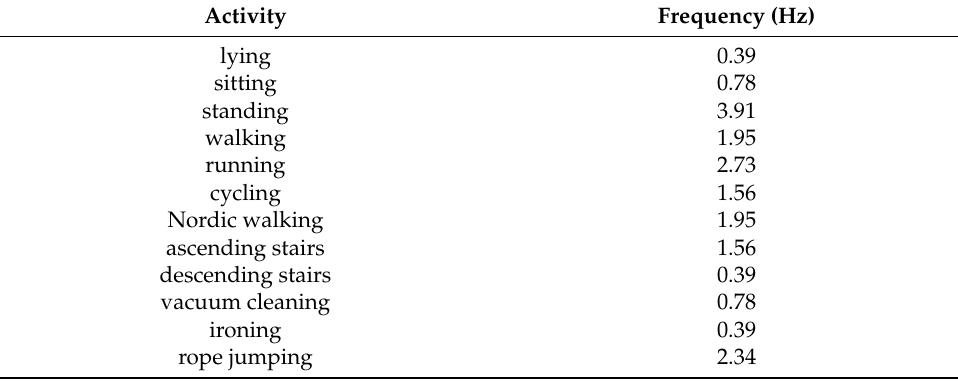
Table 6. Important frequency of each activity in PAMAP2.